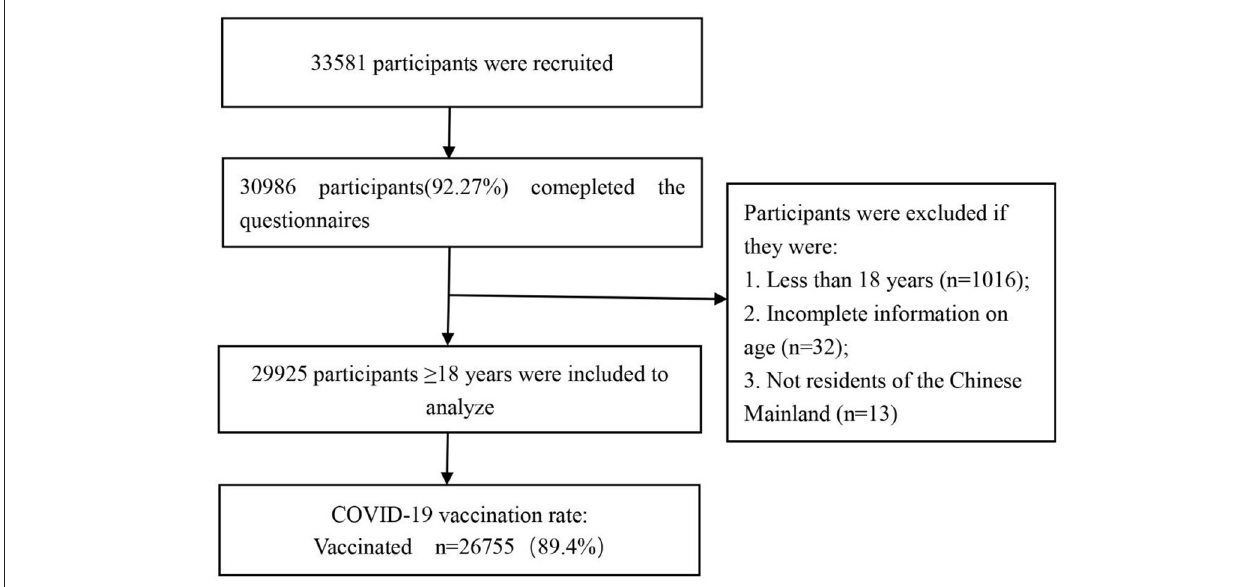
FIGURE 1 | Flowchart of data process and